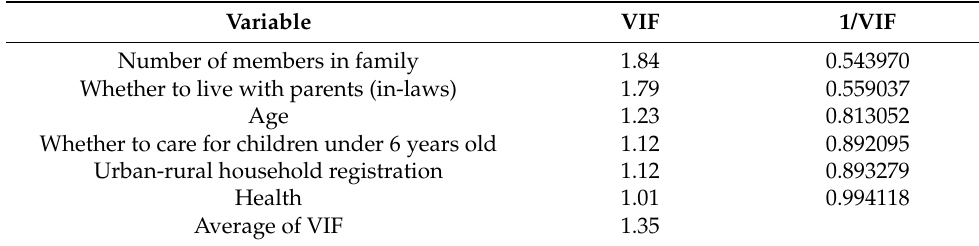
Table 2. Test results of the variance inflation